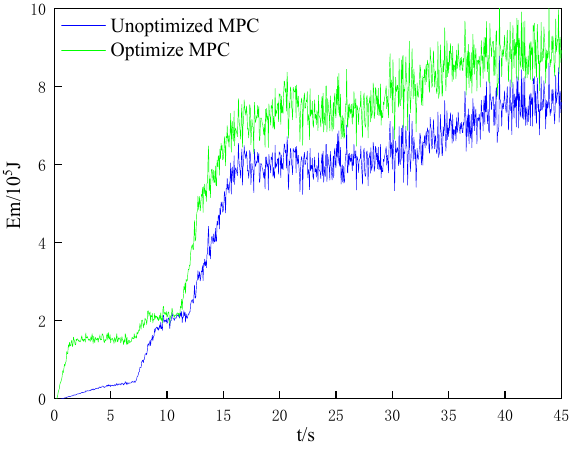
Figure 12. Energy recovery test results.